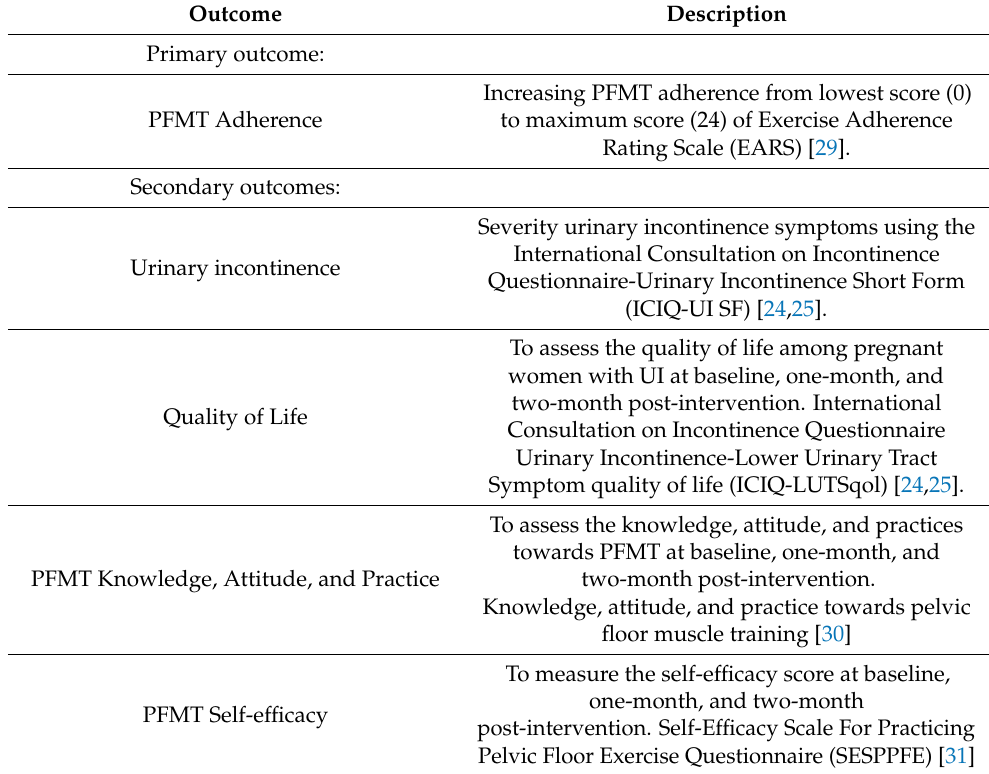
Table 2. Preliminary effectiveness